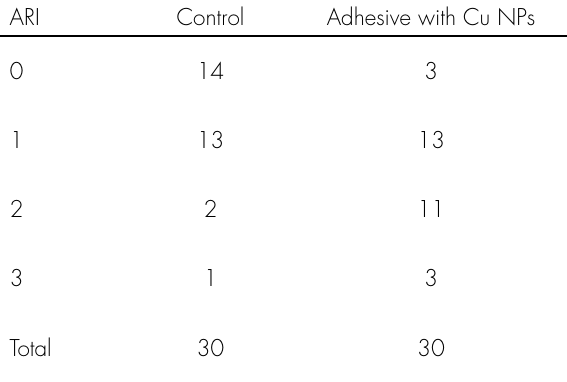
Chi square = 24.1; degree of freedom = 9; p value =